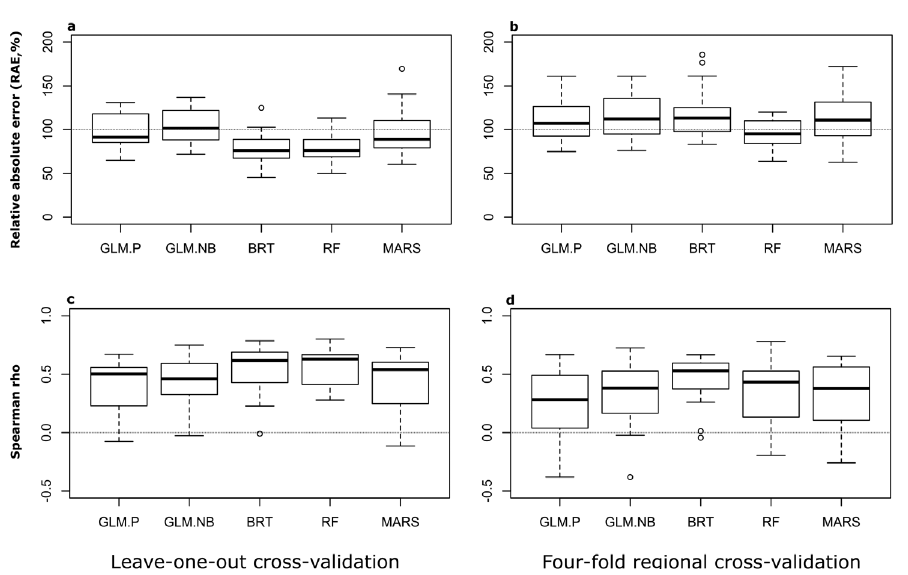
Figure 1. Detailed legend: Accuracy was measured for generalised linear models using Poisson (GLM-P) and negative binomial distributions (GLM-NB), boosted regression trees (BRT), random forests (RF) and multivariate adaptive regression splines (MARS) for predictions of the total number of alien species per region (relative absolute error, RAE; lower is better) ( a, b ) and the rank order of each region (Spearman’s rho; higher is better) ( c, d ). Boxplots represent variations in accuracy across 22 datasets of alien species richness for GLM-P, GLM-NB, RF and MARS, but not for BRT. Due to model convergence issues, re- sults for BRT comprise only a subset of datasets and are thus not directly comparable with the results of the other techniques. Panels in the right left ( a, c ) refer to predictions evaluated using a leave-one-out ap- proach, which measures the accuracy of predictions within the geographical range of the model calibration data. Panels in the right ( b, d ) refer to predictions evaluated using a four-fold regional cross-validation approach, which assesses the spatial transferability of the models. A few outliers lie outside the ranges of the Y-axes, see Tables A2 and A3 for the complete list of